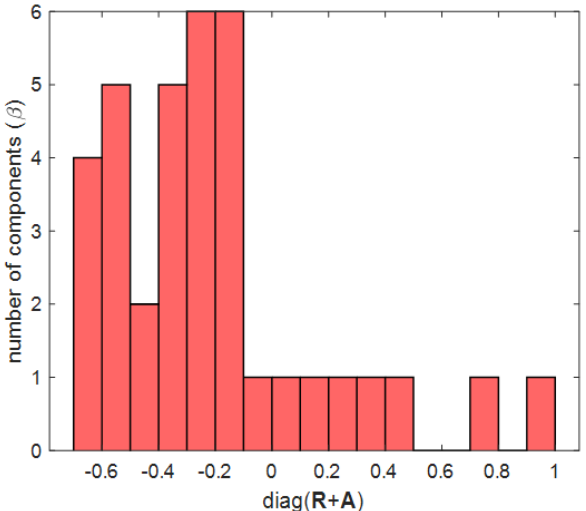
Figure 7. Histogram of diagonal component values of R , A matrix for Otsu threshold.